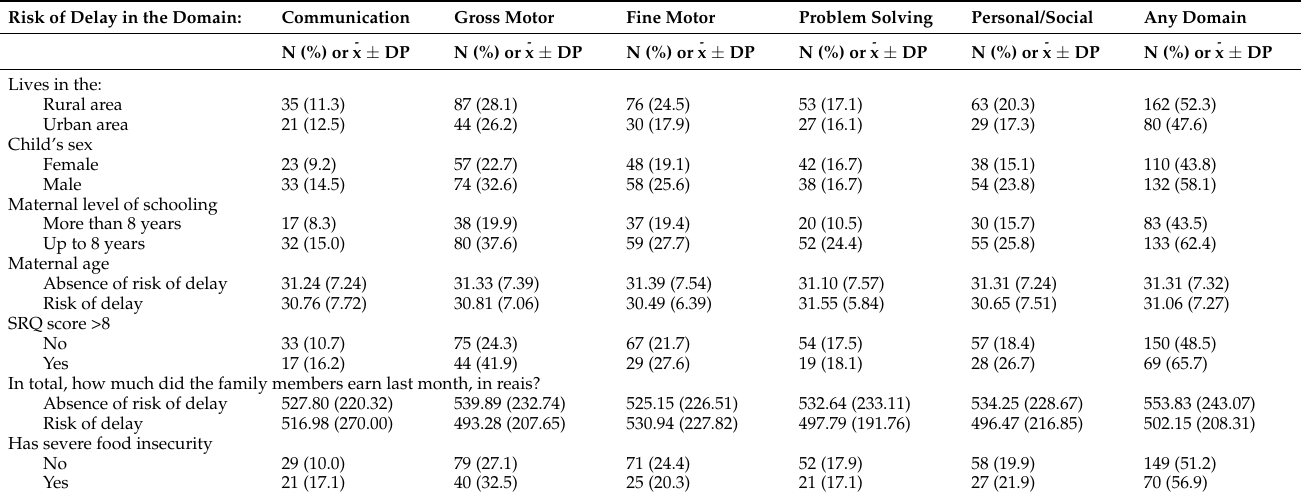
Table 3. Bivariate analysis of the association of the factors proposed as determinants of risk of delay in the child development domains.